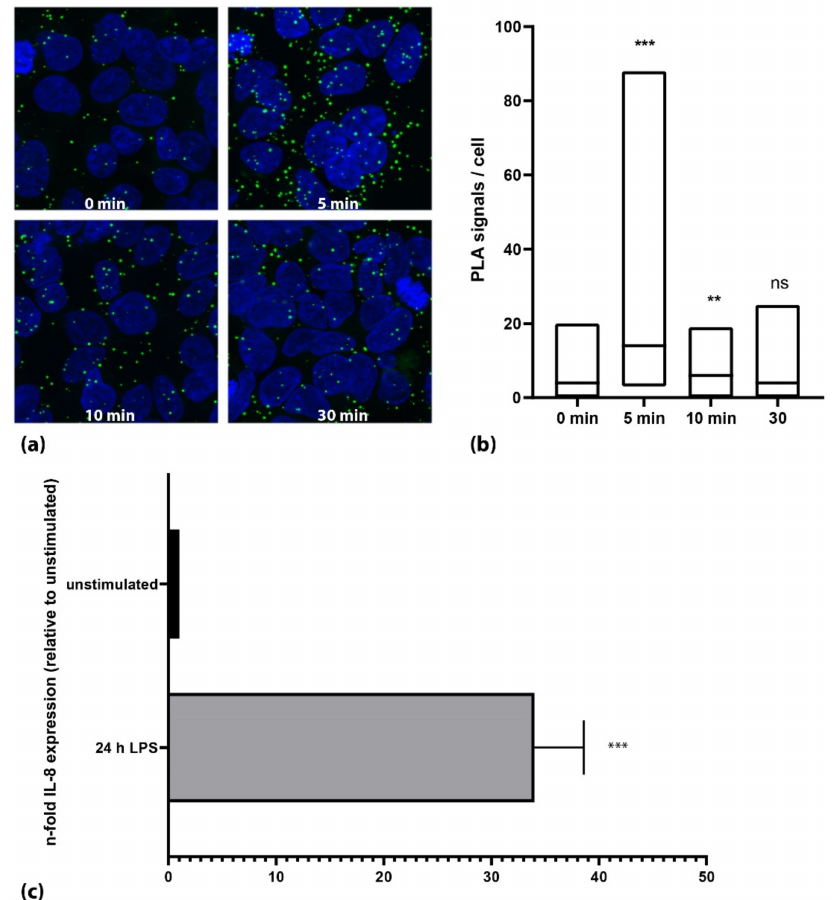
Figure 1. Activation of TLR4 in HEK293-TLR4/MD2/CD14 cells using 1 µ g/mL LPS. ( a ) Microscopic images of a representative experiment. Nuclei are shown in blue; PLA signals are shown as green dots. ( b ) Quantification of one representative experiment. The cells showed a marked increase in phosphorylation of TLR4 5 min after stimulation with LPS ( p < 0.001; Mann–Whitney U test). Activation decreased subsequently to approximately ground state levels. Black lines in the box plots represent the median. ( c ) Stimulation of HEK293-TLR4/MD2/CD14 cells with LPS for 24 h showed a strong increase in IL-8 mRNA expression. (***: p < 0.001, **: p < 0.01, ns: not significant; p >